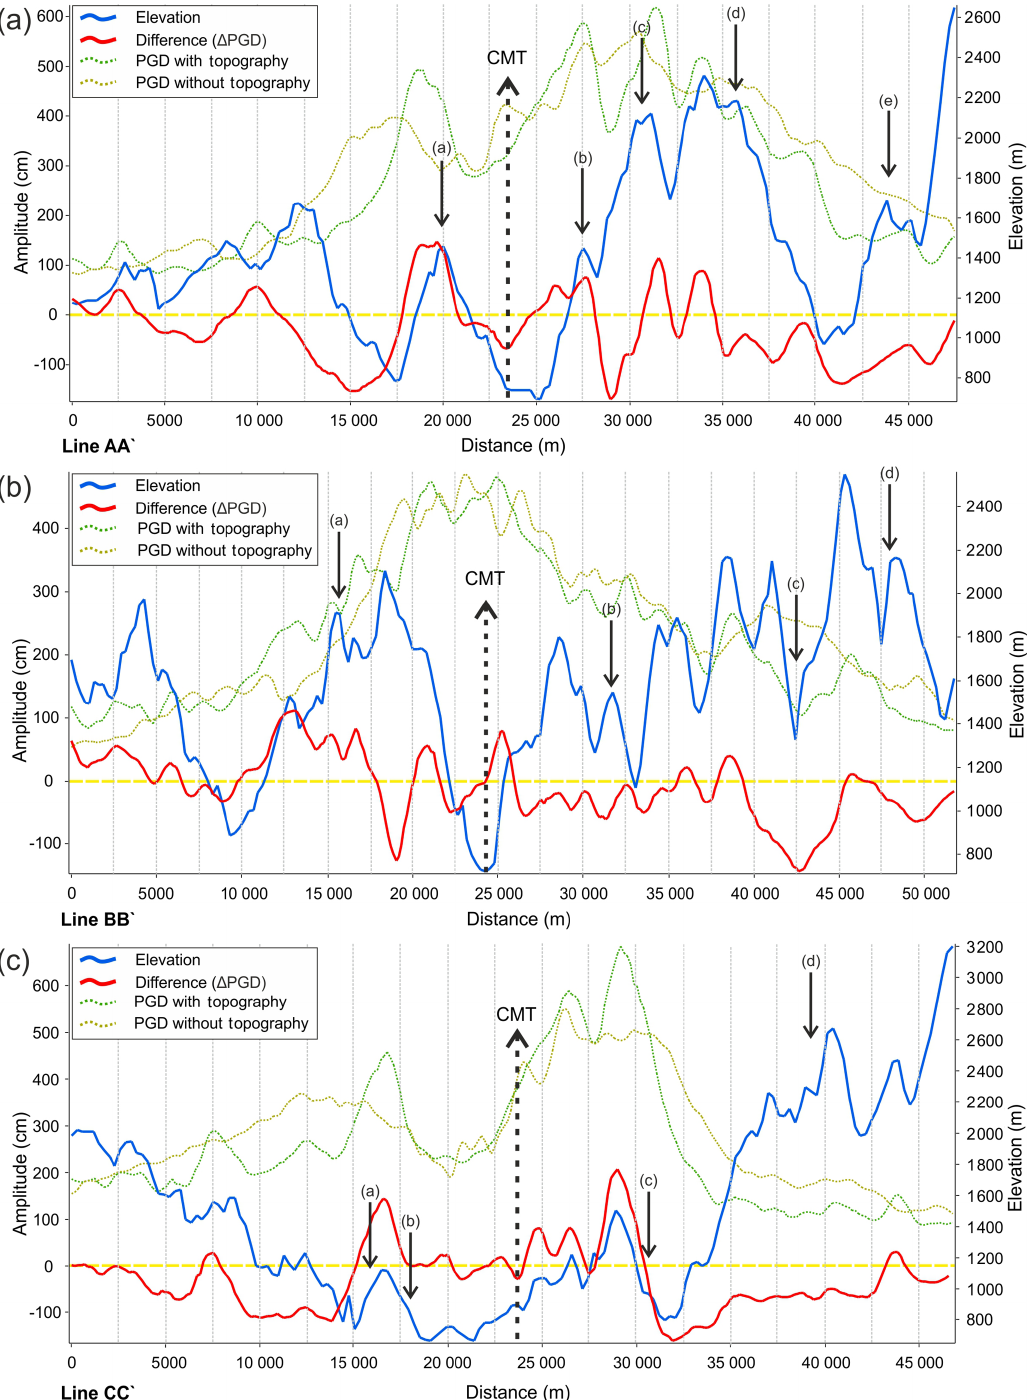
Figure 5. Profile along line (a) AA’, (b) BB’ and (c) CC’ (Fig. 4) of PGD with topography (dotted green) and without topography (dotted olive), their difference ( (cid:49) PGD, solid red) and elevation (solid blue). PGD are scaled on the left y axis, along the line, and elevation is shown on the right y axis. The profile line passes over the CMT location, which is located approximately in the center of the profile, marked with a dotted arrow